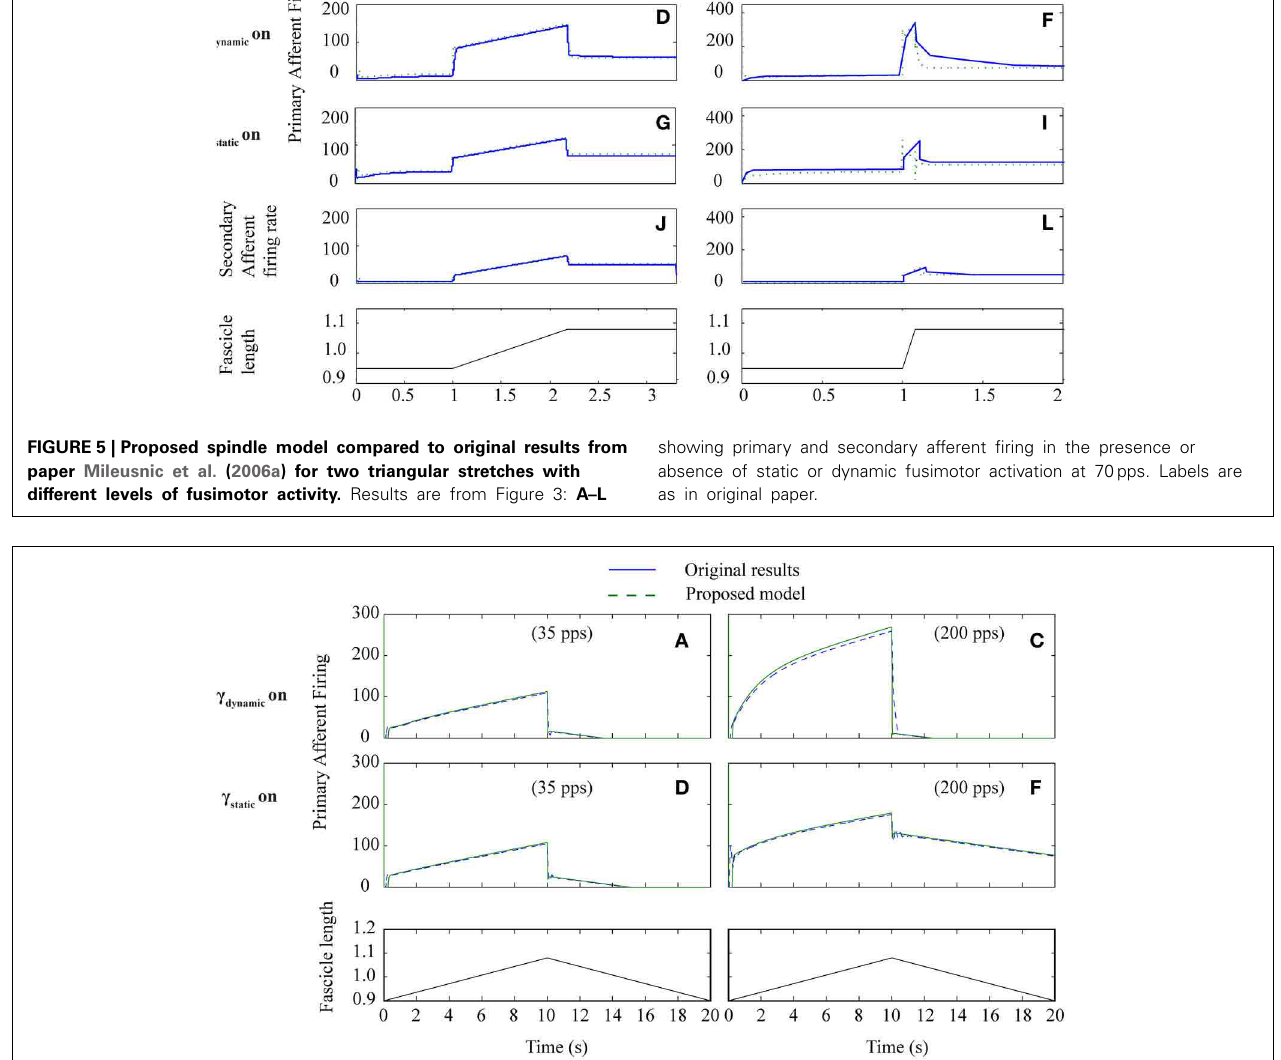
FIGURE 6 | Proposed spindle model compared to original results (Figure 4) from paper Mileusnic et al. (2006a) for triangular stretches with different levels of fusimotor activity. Results are from